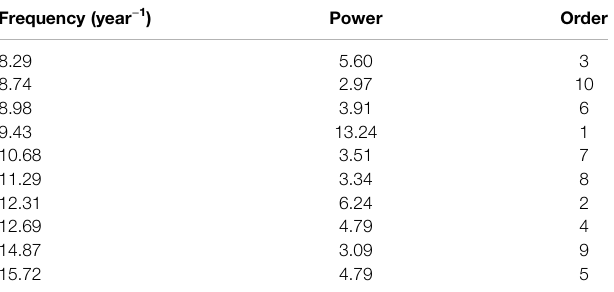
TABLE 1 | The top 10 peaks in the frequency band 6 – 16 year − 1 in the power spectrum derived from Super-Kamiokande measurements by a likelihood procedure that takes account of the start time and end time of each bin, the fl ux estimate at the mean live time, and the upper and lower error